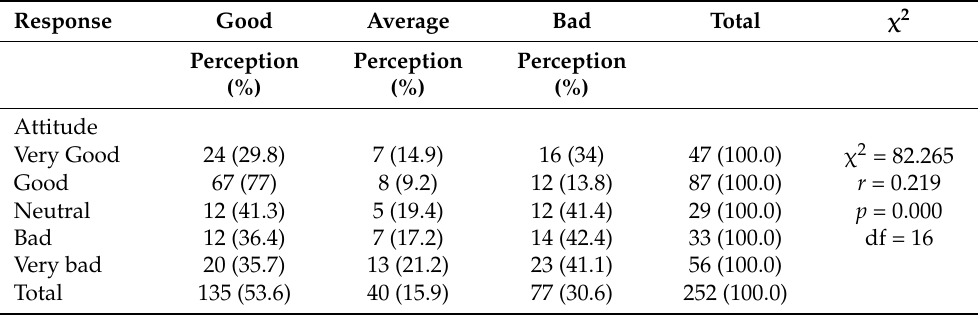
Table 4. Relationship between attitudes of medical personnel during outpatient care and enrolees’